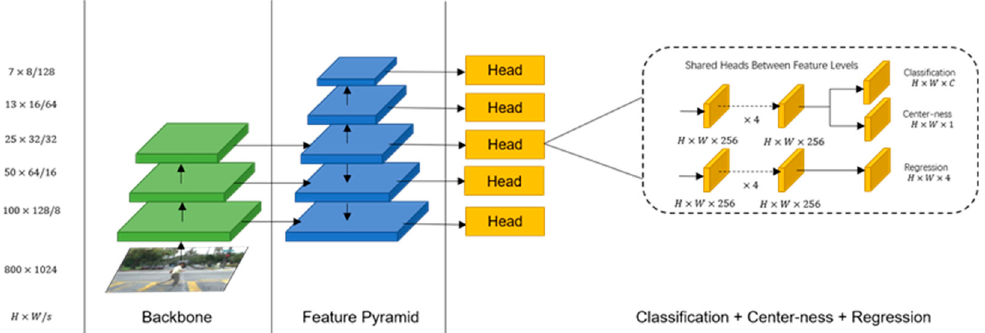
Figure 1. FCOS overall structure.